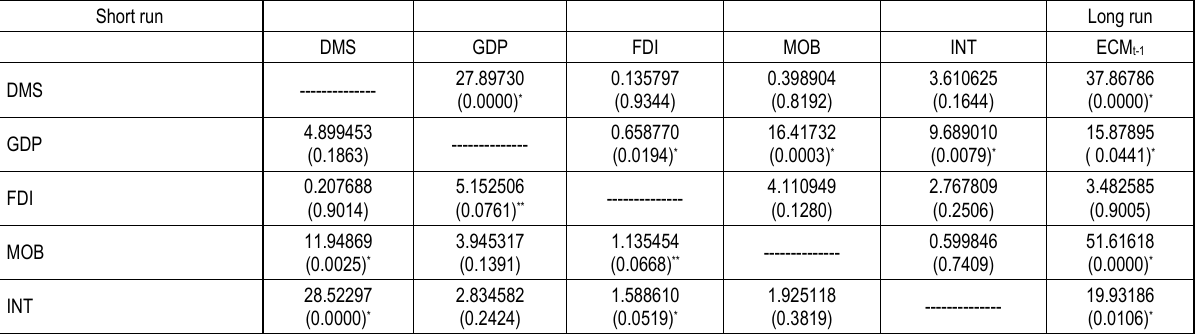
Table 7. The VECM Granger